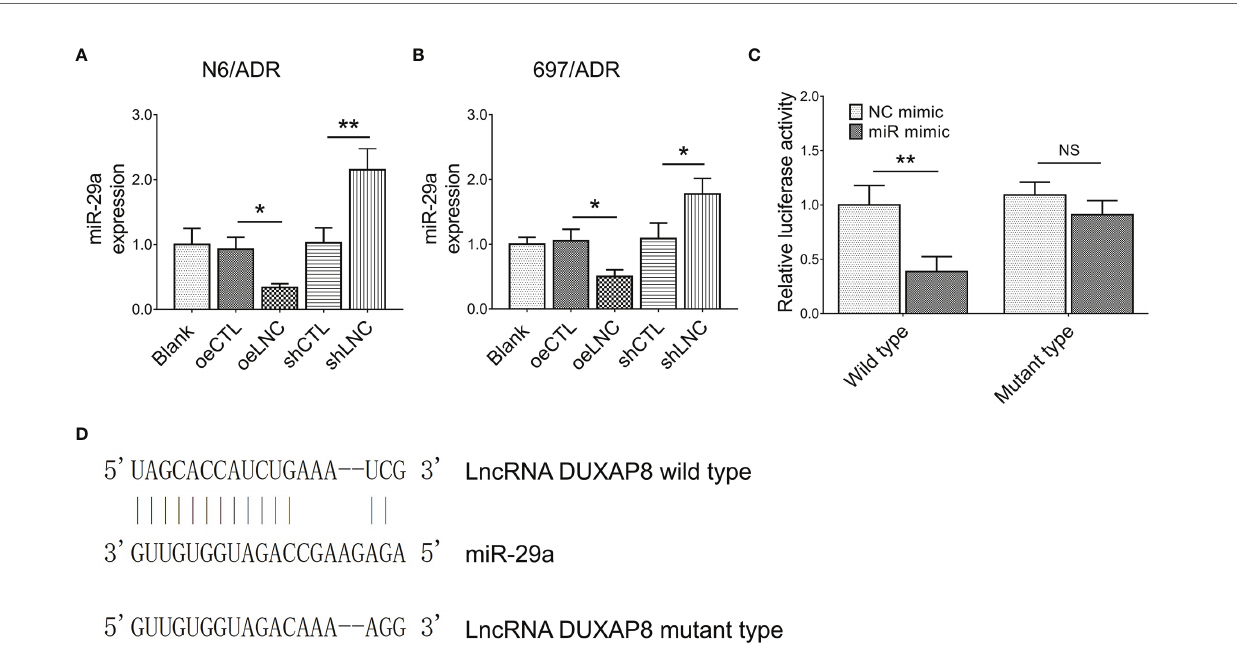
FIGURE 4 | Interaction between lncRNA DUXAP8 and miR-29a. MiR-29a expression among blank, oeCTL, oeLNC, shCTL, and shLNC groups in N6/ADR cells and 697/ADR cells (A, B) . Luciferase reporter gene assay results (C) and binding site between lncRNA DUXAP8 and miR-29a (D)